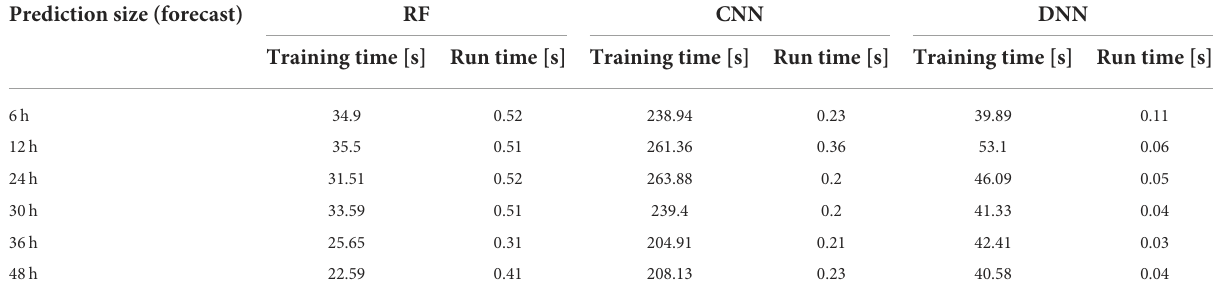
TABLE 6 The computational time of training and running the model on a single 1.7 GHz Intel Core i7 processor for each ML model type and prediction lead-time. Prediction size